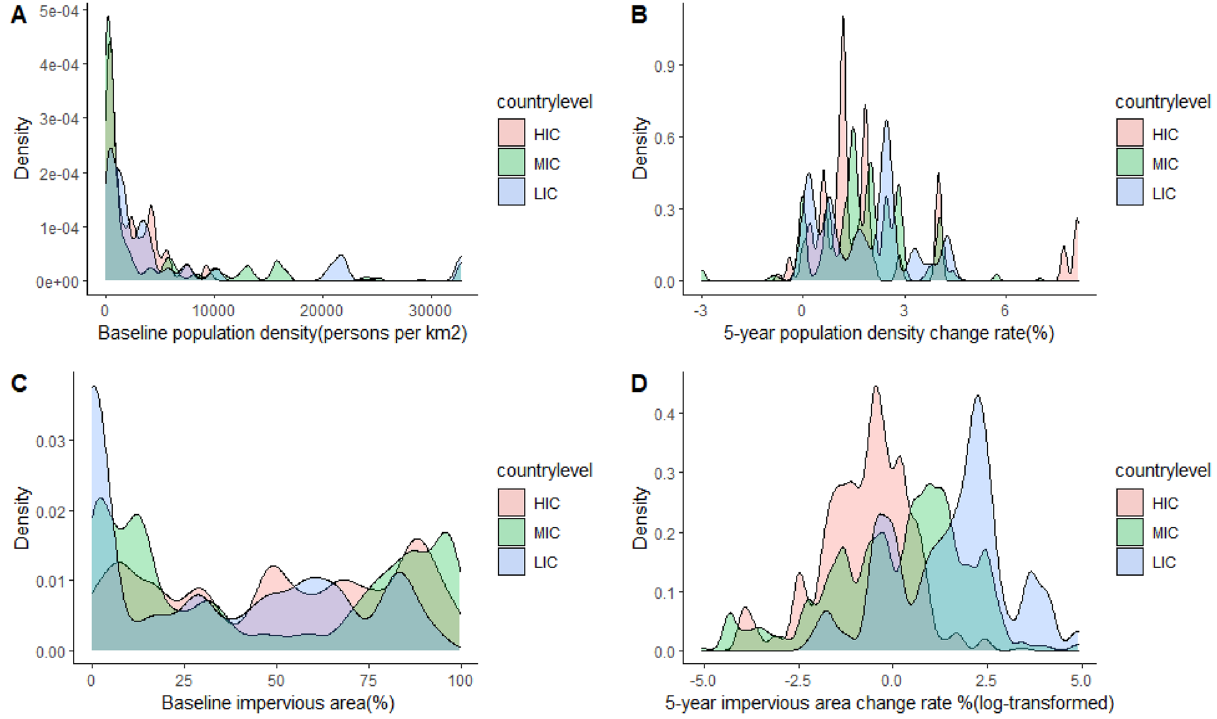
Figure 1. Baseline and 5-year change measures of community population density and impervious surface area for 138,206 PURE participants.